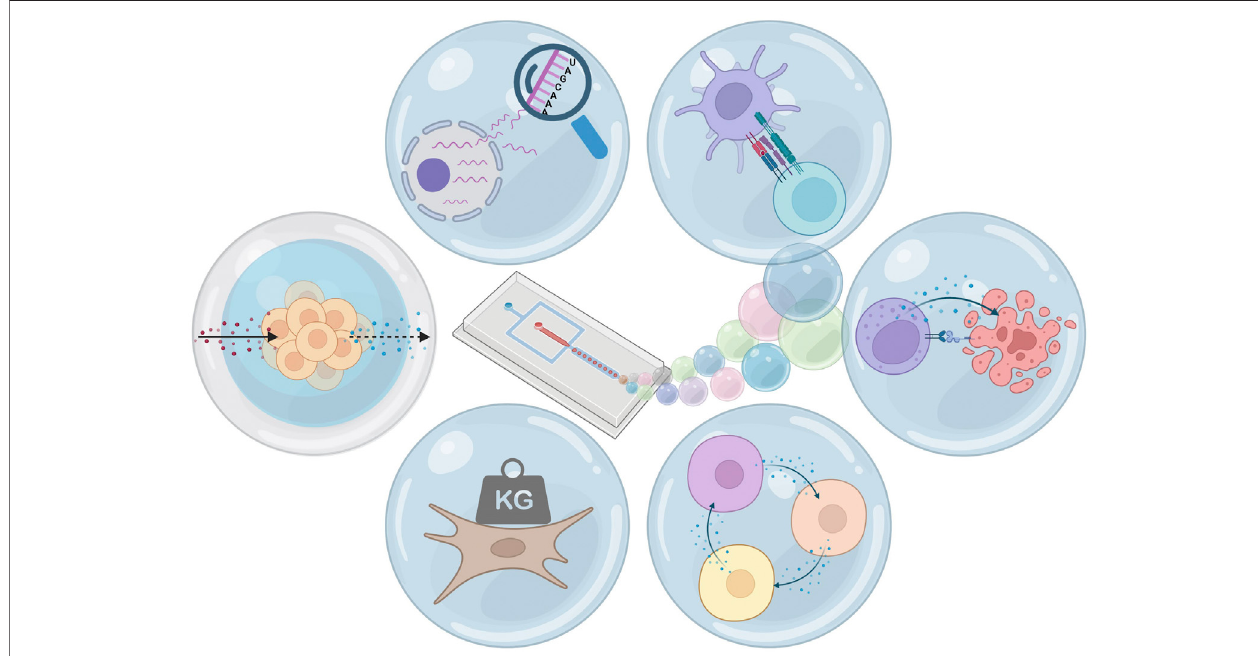
FIGURE 1 | Hydrogel micro fl uidic droplets: applications. From top-left clockwise: single-cell sequencing, pairing for cell interaction, pairing for cytotoxicity, coculture, changing and measurement of mechanical properties, and selectively permeable hydrogel shells. Figure created using Biorender.